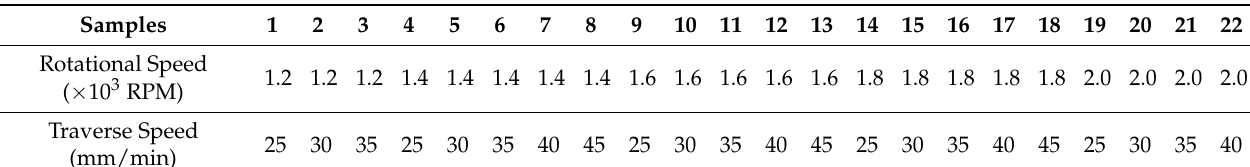
Table 2. FSPed samples with different processing parameters.